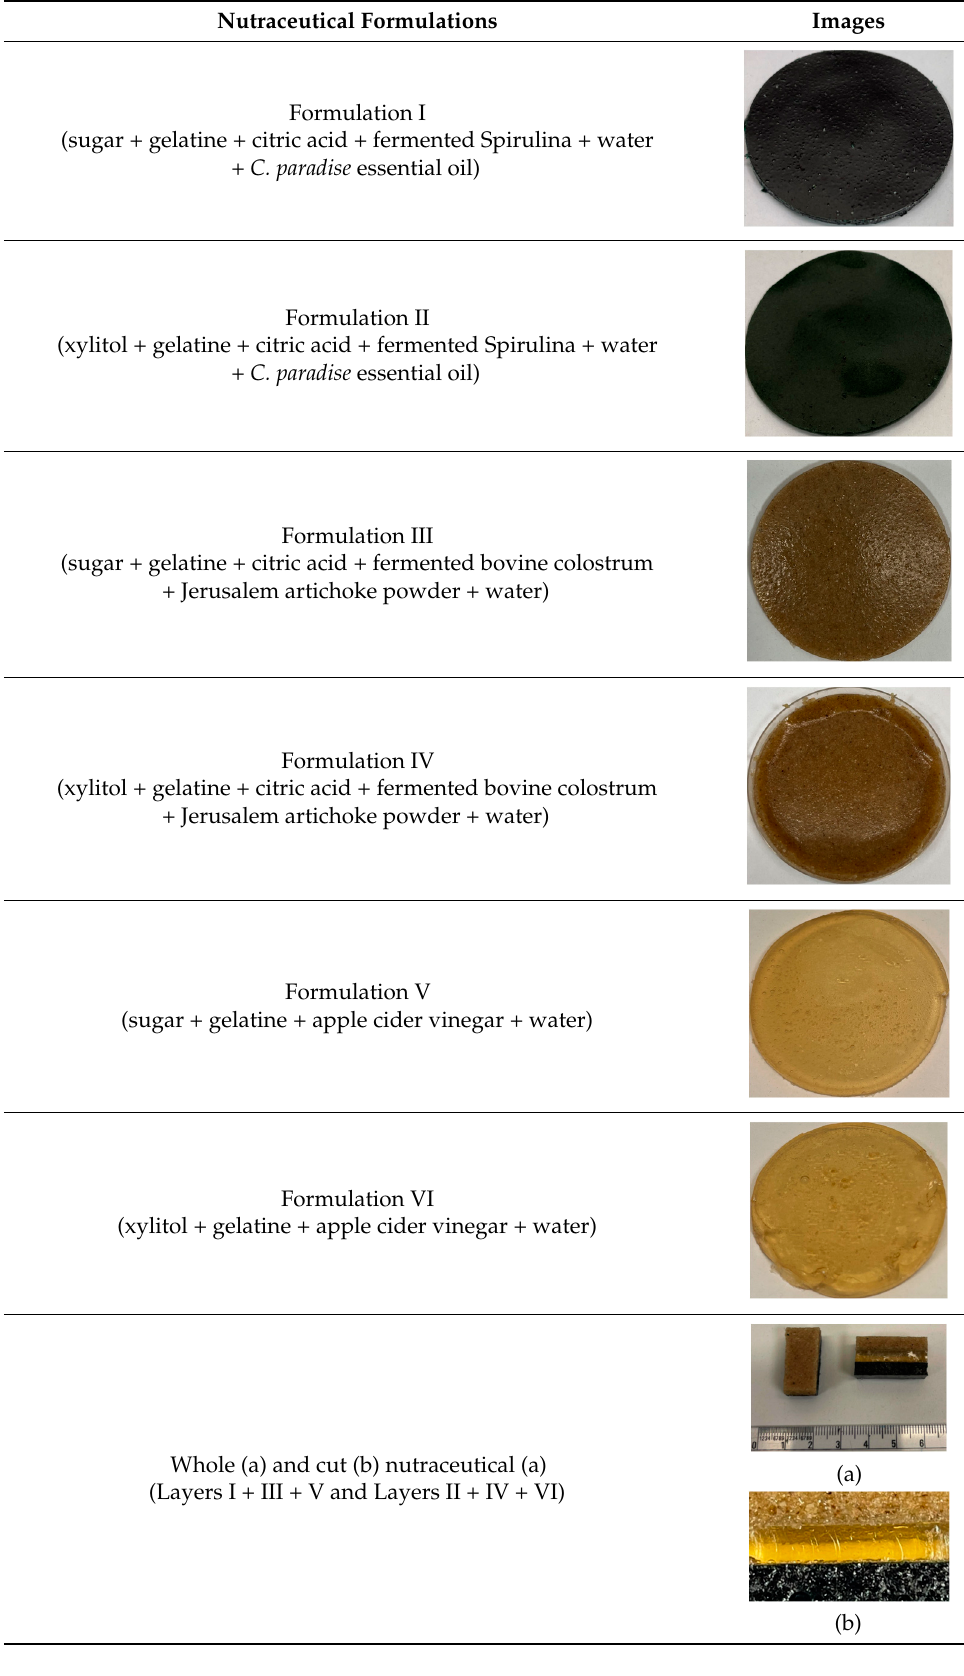
Table 3. Colour coordinates and texture hardnesses of the separate nutraceutical layers and overall acceptability of the separate layers and fi nal products.